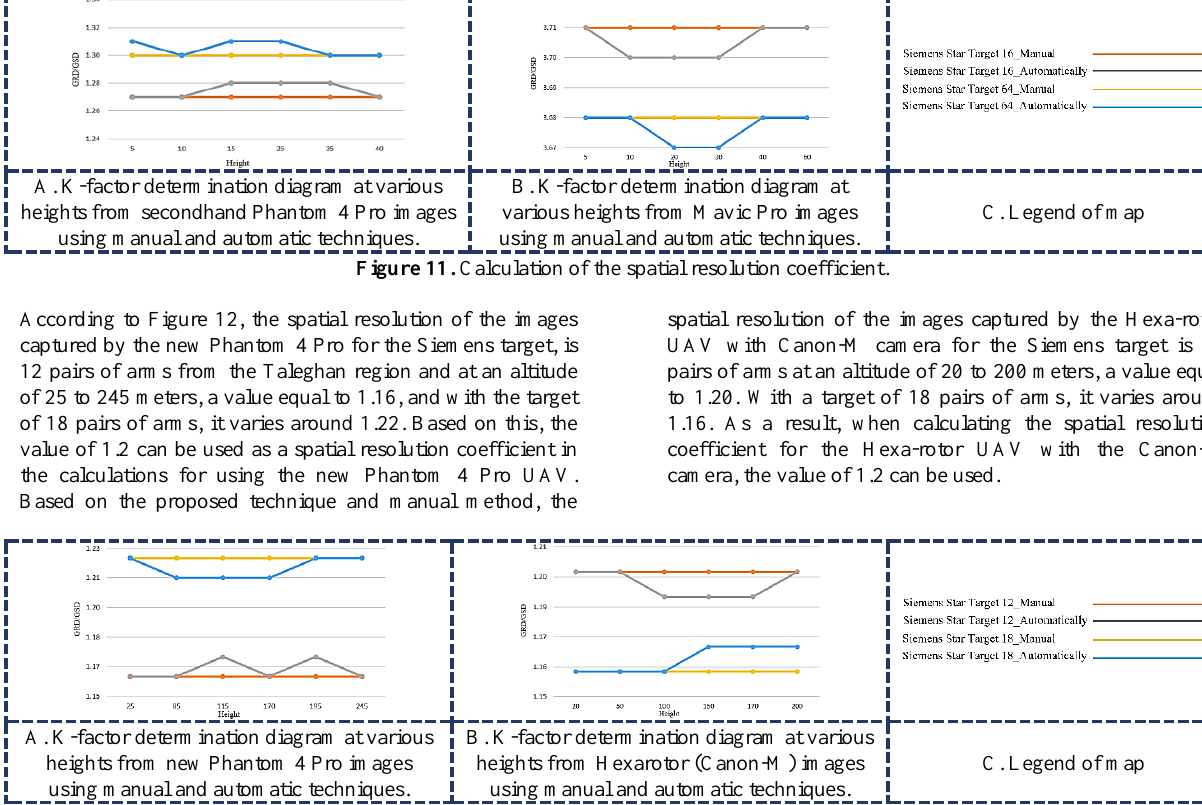
Figure 12. Calculation of the spatial resolution